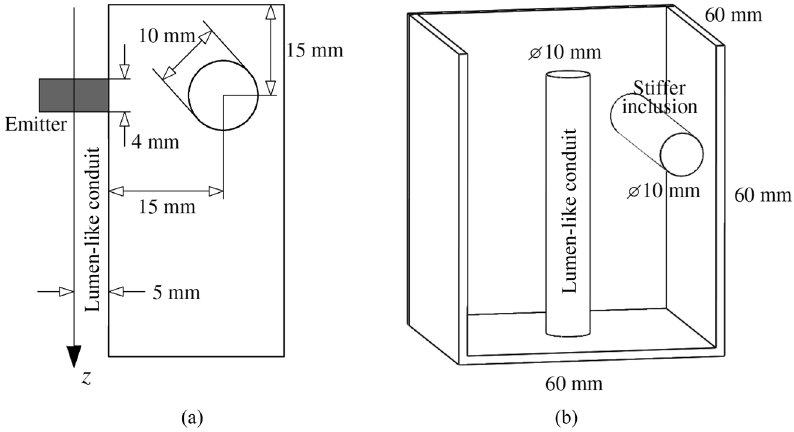
Figure 3. ( a ) Configuration and dimensions of the wave propagation model scenario used for designing the phantoms. ( b ) Mould design for casting the phantoms. The front face has been removed to ease visualisation.